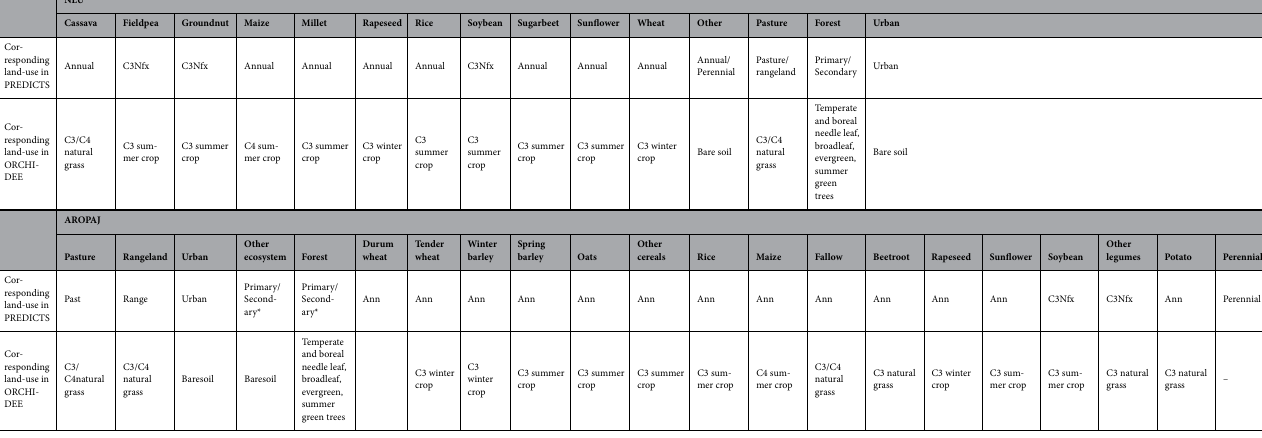
Table 1. Table of correspondences between the land uses and crops represented in the AROPAJ/NLU and ORCHIDEE models and PREDICTS. Crops or land uses in NLU or AROPAj that are found in more than one land use in PREDICTS or ORCHIDEE are allocated between land-uses according to the rules described in “Overview of modeling framework”